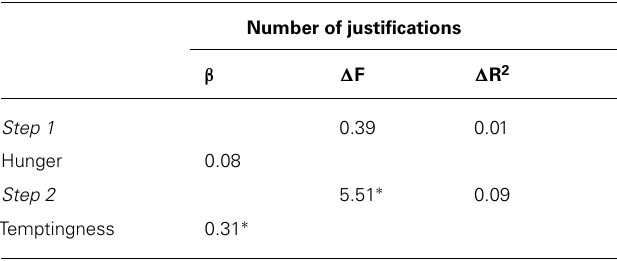
Table 2 | Hierarchical multiple regression analysis for number of justifications (Study